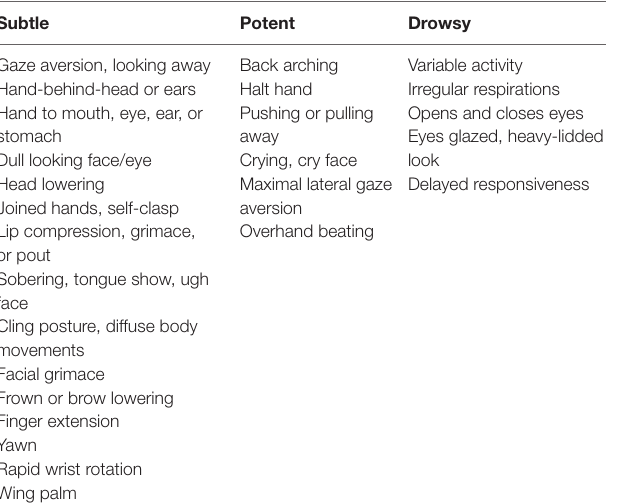
taBlE 1 | Subtle disengagement, potent disengagement, and drowsy cues (34). Subtle Potent